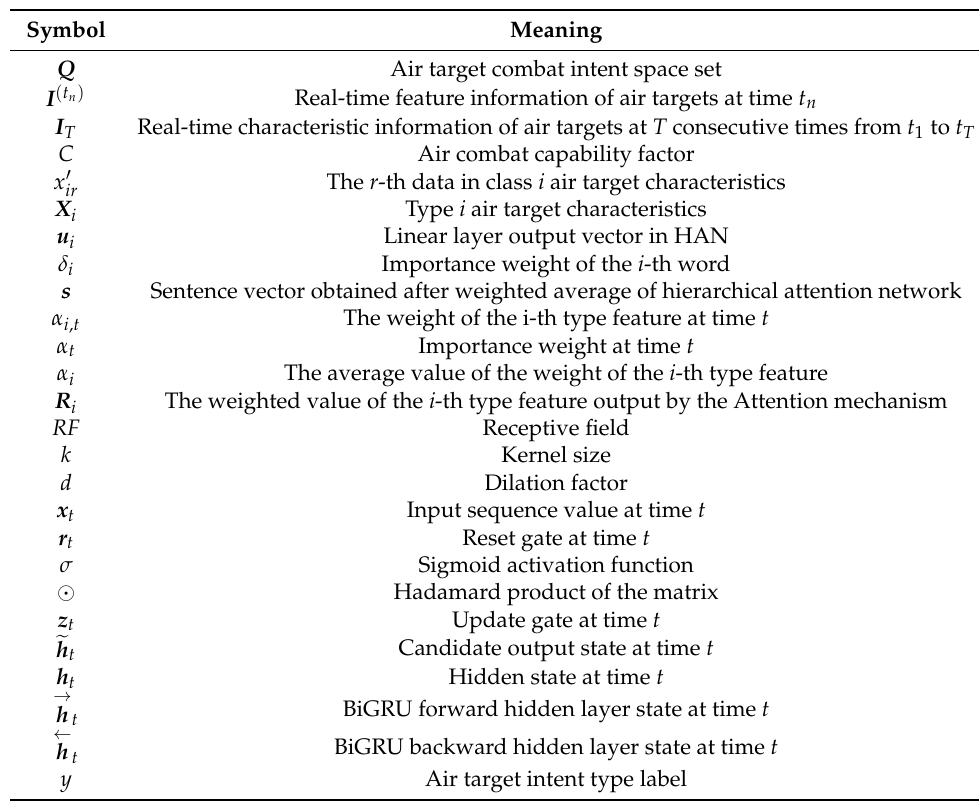
Table A2. Symbol